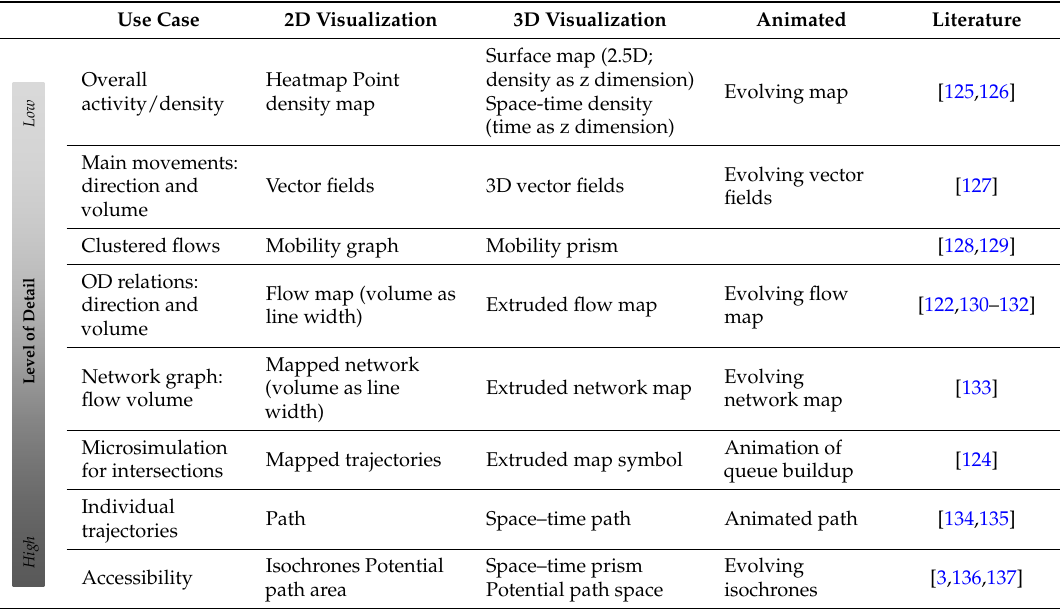
Table 1. Visualization concepts for selected use cases.